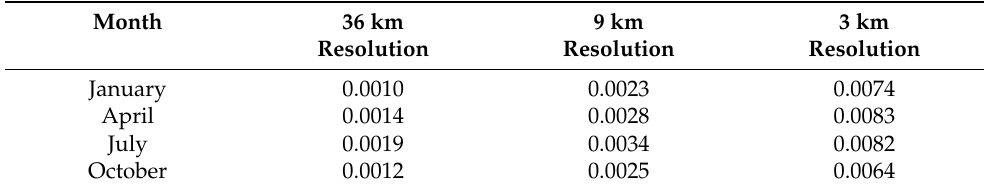
Table 2. Mean difference in cm 3 cm − 3 for soil moisture produced at several resolutions compared to validated products. A positive difference suggests that the algorithm tends to overestimate, while a negative difference suggests